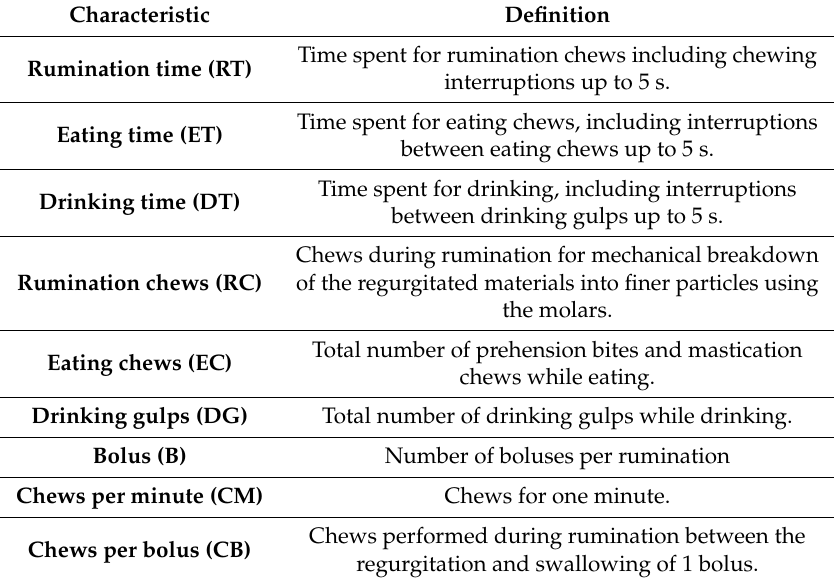
Table 1. Behavioural characteristics of cattle a ffl icted by subclinical ketosis as measured by